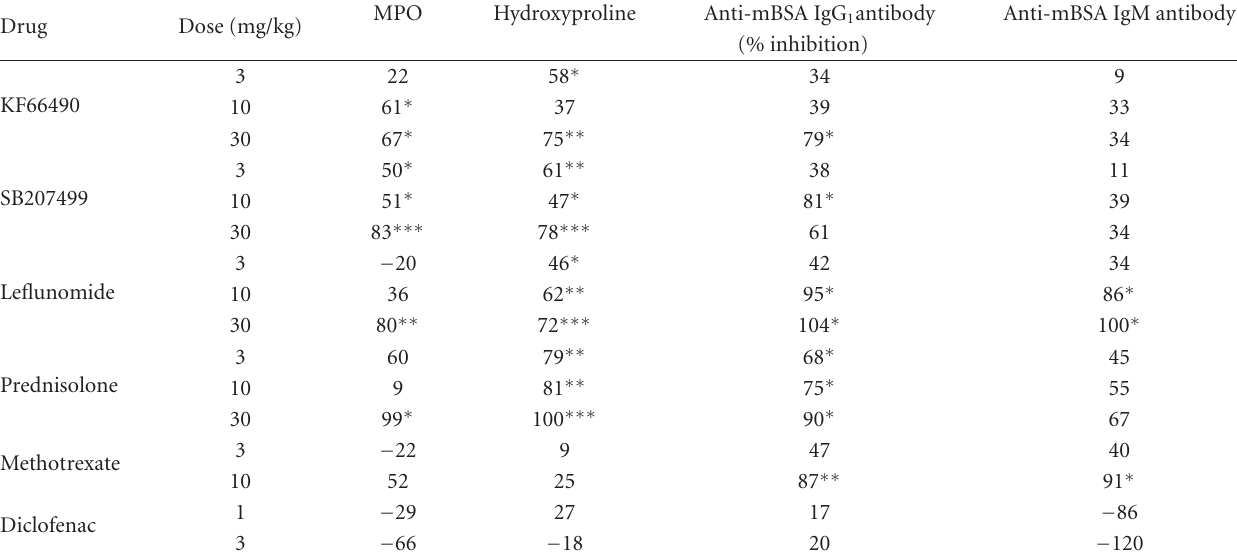
Table 2: Summary of MPO activity, hydroxyproline content, anti-mBSA IgG 1 , and anti-mBSA IgM antibody